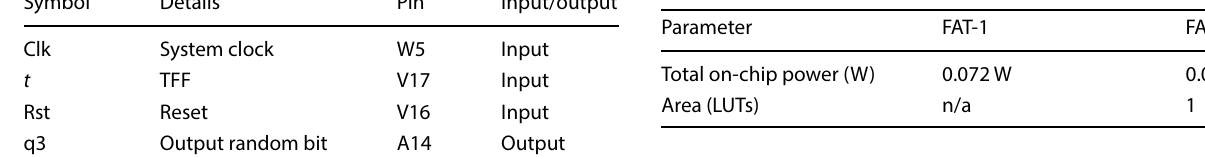
Fig. 12 Pre-processing block diagram